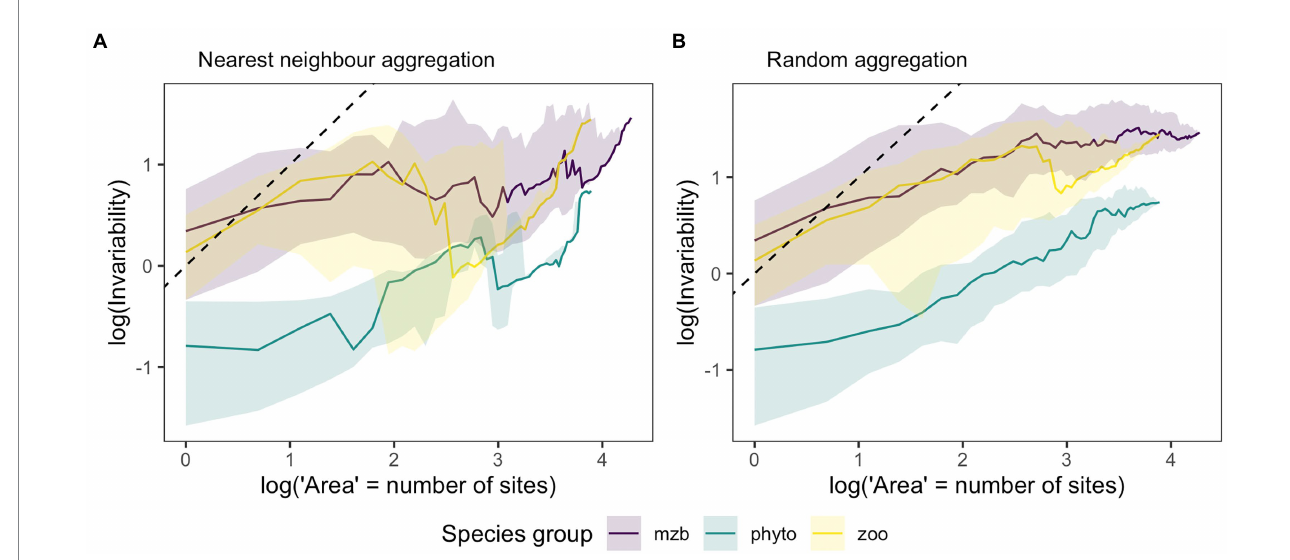
FIGURE 4 Medians of the invariability-area relationships (IAR) for the phytoplankton (phyto, green), zooplankton (zoo, yellow) and macrozoobenthos (mzb, purple) data sets. Higher invariability, i.e., the inverse of the squared coefficient of variation of aggregated biomass on the y-axis stands for lower temporal biomass fluctuations at a given spatial scale (x-axis), which is represented by the log number of sites that biomass measurements were aggregated over. (A) IARs resulting from spatially nested biomass aggregation, i.e., adding the biomass of the next closest sampling location. (B) IARs generated by randomly drawing a sampling location and adding its biomass for the calculation of invariability at the next higher unit of spatial scale. Shaded areas represent 25 and 75% quantiles. The number of IARs used to calculate the median and quantiles matches the number of sampling locations as each sampling location was used as the starting point for spatial aggregation and IAR calculation once. The black dashed line represents the 1:1 line, which stands for the absence of correlations between local